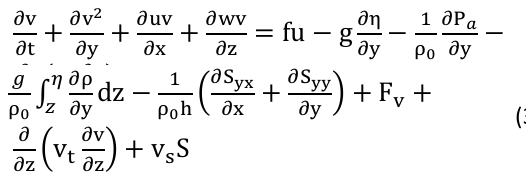
Fig. 1: Geographic location of the study area and station sampling in Misool, West Papua, Indonesia Hydrodynamic modeling The ecological processes of Misool waters were approached using the three-dimensional (3D) numerical model by using MIKE3. Numerical solutions are based on the Navier-Stokes equation, the Boussinesq approximation, and hydrostatic pressure. The turbulent waters conditions were determined using the eddy viscosity concept. Turbulence parameters using the standard k- ε (Canuto et al., 2001) and vertical eddy viscosity using the concept of Smagorinsky (1963). The continuity is used as Eq. 1.